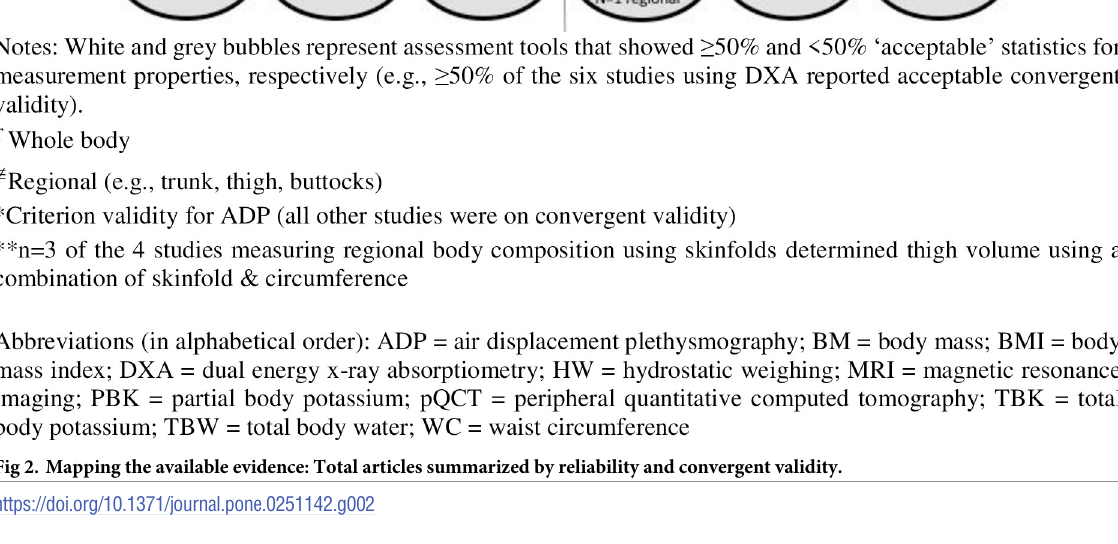
Fig 2. Mapping the available evidence: Total articles summarized by reliability and convergent validity.